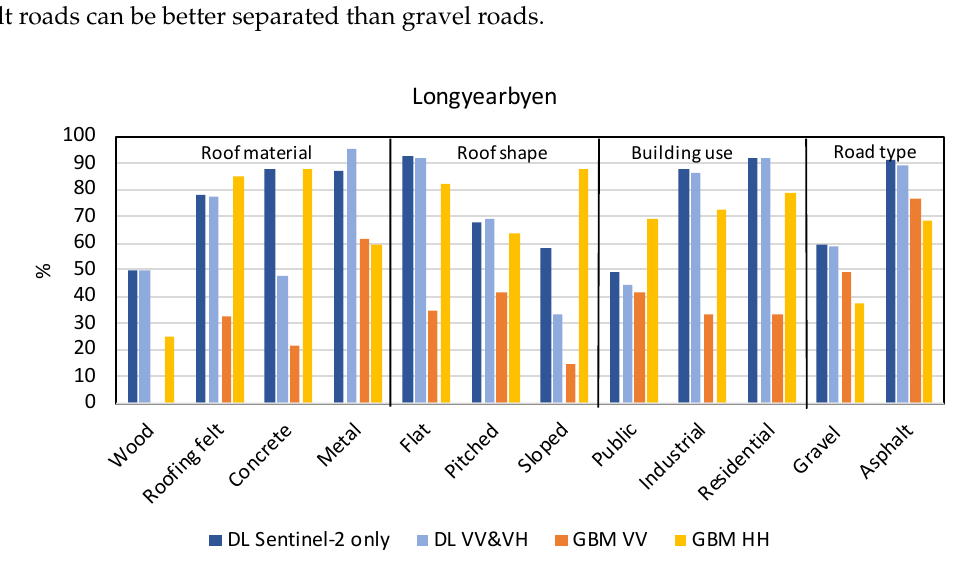
Figure 11. Classification performance results for surface types in Longyearbyen, Svalbard (validation data source [54]). DL—Deep Learning, GBM—Gradient Boosting Machines, V—vertical polarization, H—horizontal